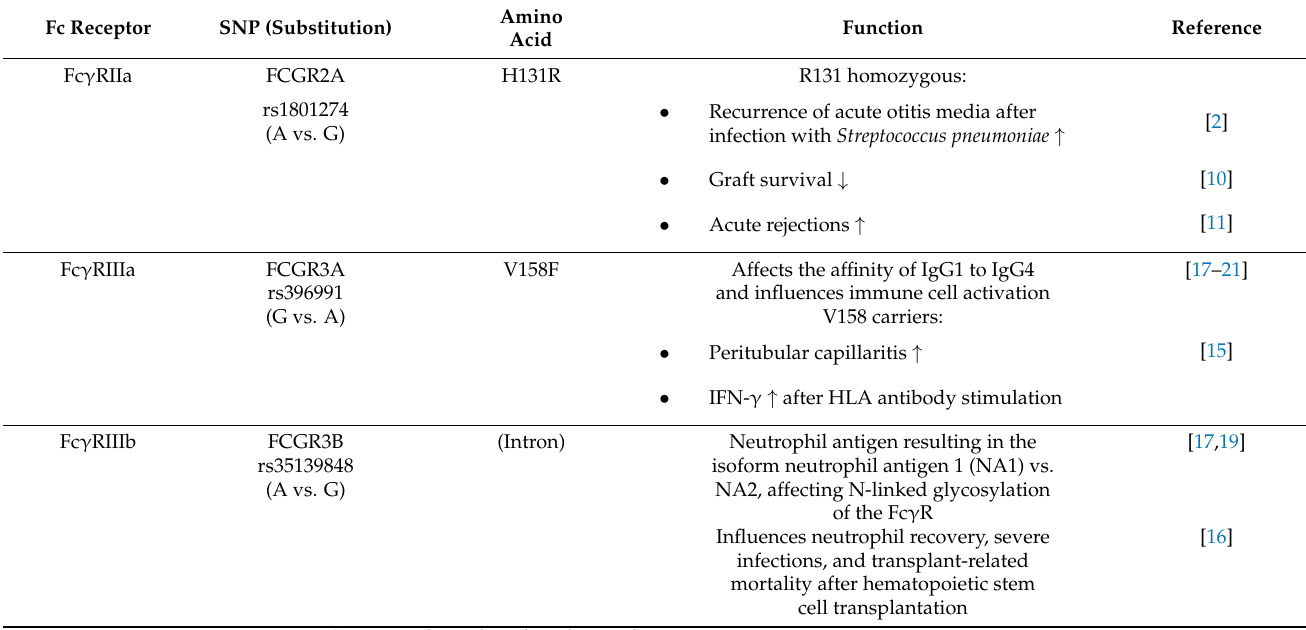
Table 1. Previous functional data on Fc γ receptor